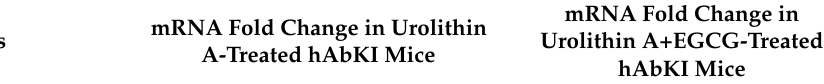
mRNA Fold Change in Urolithin A+EGCG-Treated hAbKI Mice